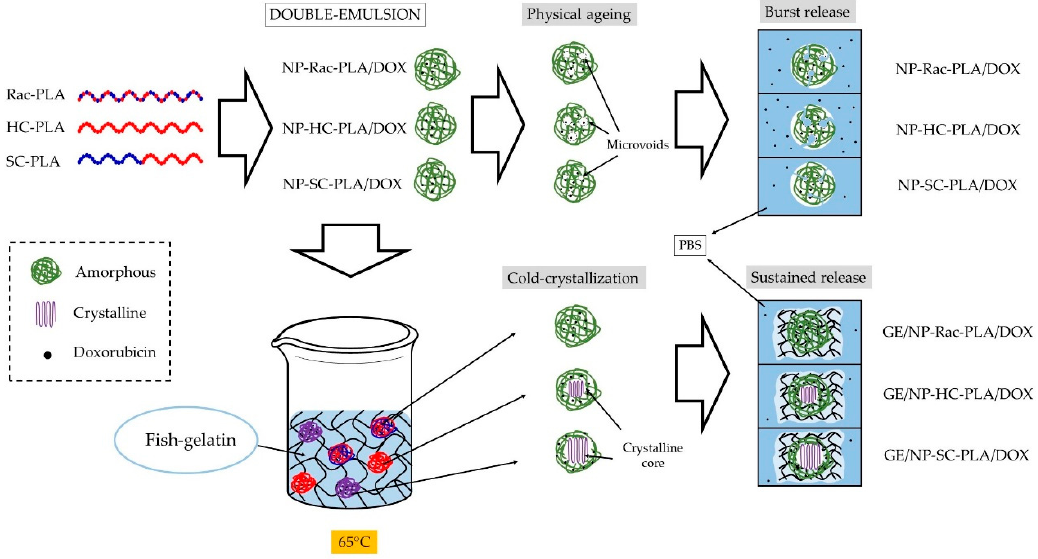
Figure 10. Mechanism of bionanocomposites formation and the drug release.